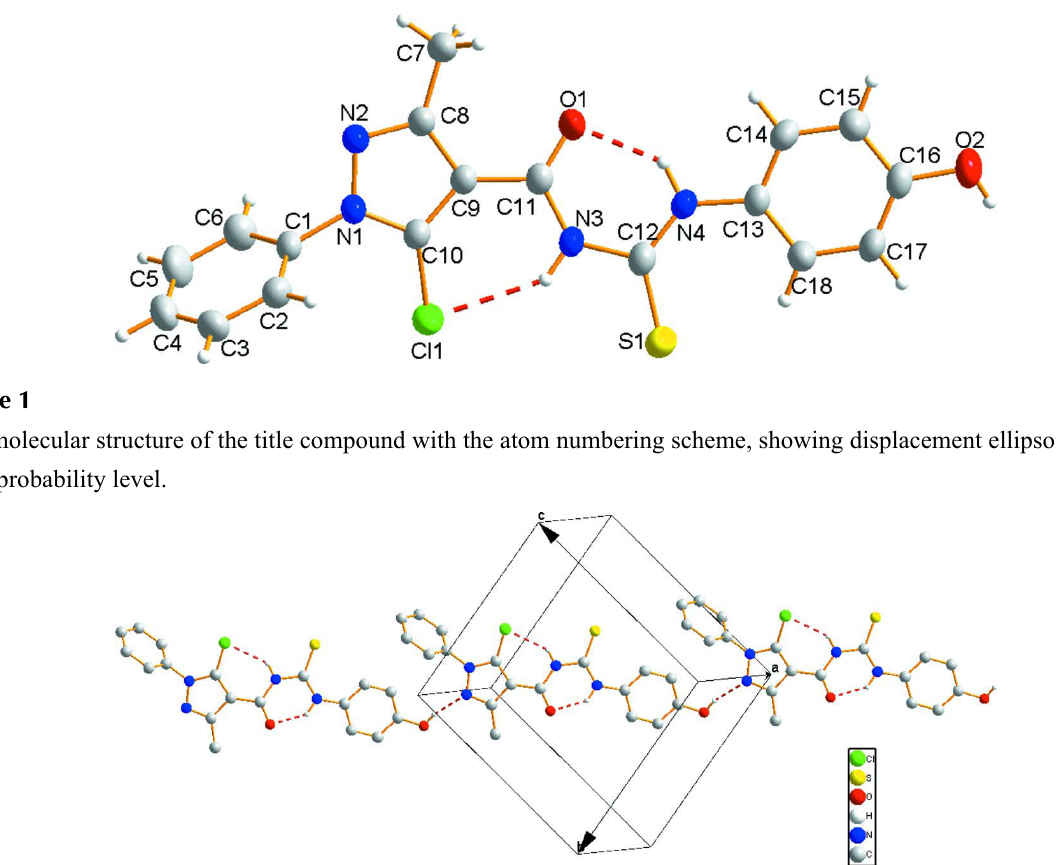
The polymeric structure via O-H···N hydrogen bonds. Hydrogen bonds are shown with dashed